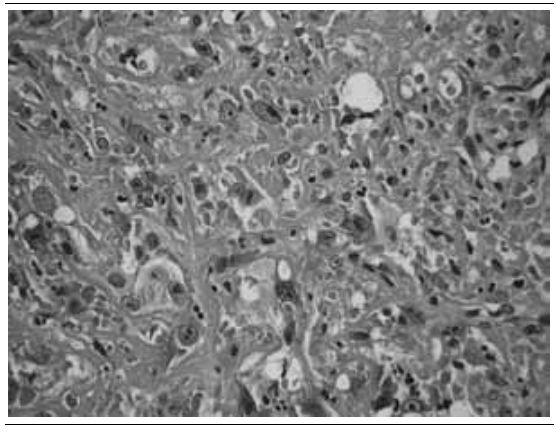
stroma. HEE: epithelioid hemangioendothelioma; HE: hematoxylin and